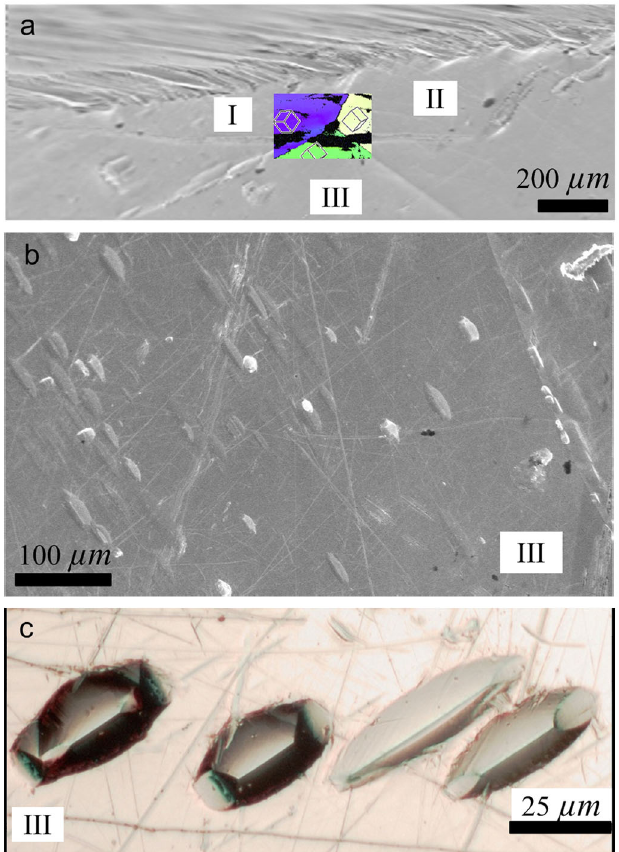
FIG. 5. SEM images of pits which have complex symmetrical geometry observed on samples No. 2 (a), No. 8 (e), and No. 1 (b), (c), (d), (f).FIG. 4. Pits distributed nonuniformly on the three grains